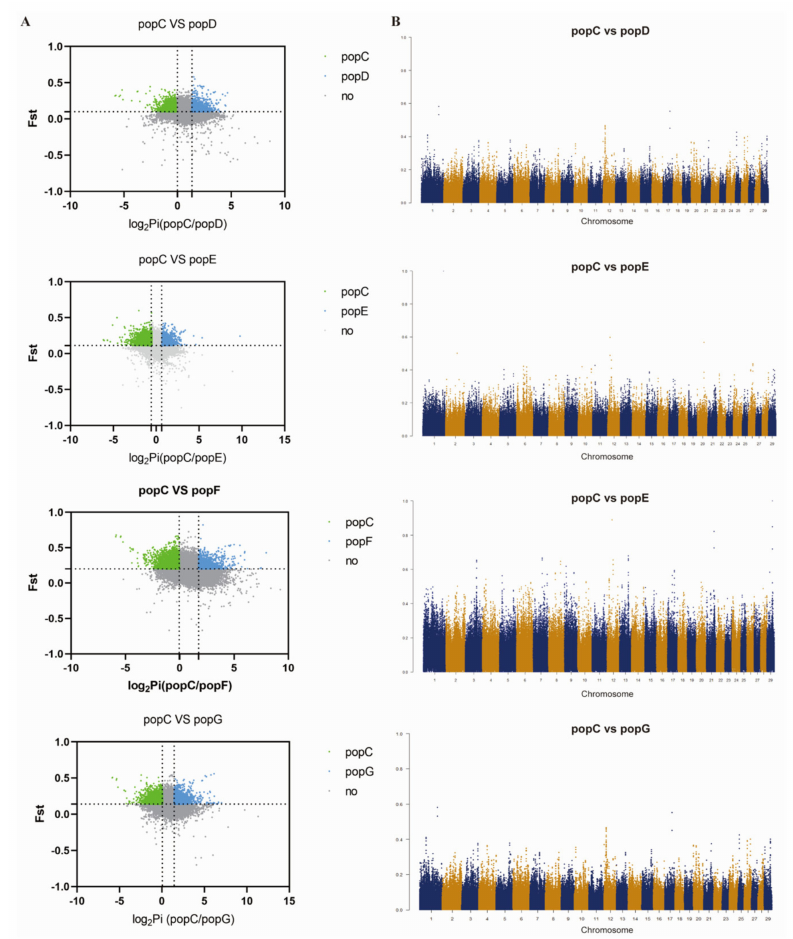
Figure 6. ( A ) Genomic regions with selective sweep signals in the popC (Hainan Black goat) group and the popG (Alashan Cashmere goat), popF (Boer goat), popE (Jining Grey goat), and popD (Dazu Black goat) groups. Distribution of the θπ ratios ( θπ , domestic/ θπ , Tibetan) and Fst values, which are calculated in 20 kb window, sliding in 5 kb steps. Data points located to the left and right of the left and right vertical dashed lines, respectively (corresponding to the 5% left and right tails of the empirical θπ ratio distribution) and points above the horizontal dashed line (the 5% right tail of the empirical Fst distribution) were identified as the selected regions. The data point in green represents genomic regions with strong selective sweep signals in the popC (Hainan Black goat), the data point in blue represents genomic regions with strong selective sweep signals in each of the other groups compared with the popC group, and the data point in grey represents genomic regions without strong selective sweep signals. ( B ) Overview of the selective sweeps in the popC (Hainan Black goat) group and the popG (Alashan Cashmere goat), popF (Boer goat), popE (Jining Grey goat), and popD (Dazu Black goat) groups. Yellow and dark blue areas are used to distinguish selective sweep signals between different